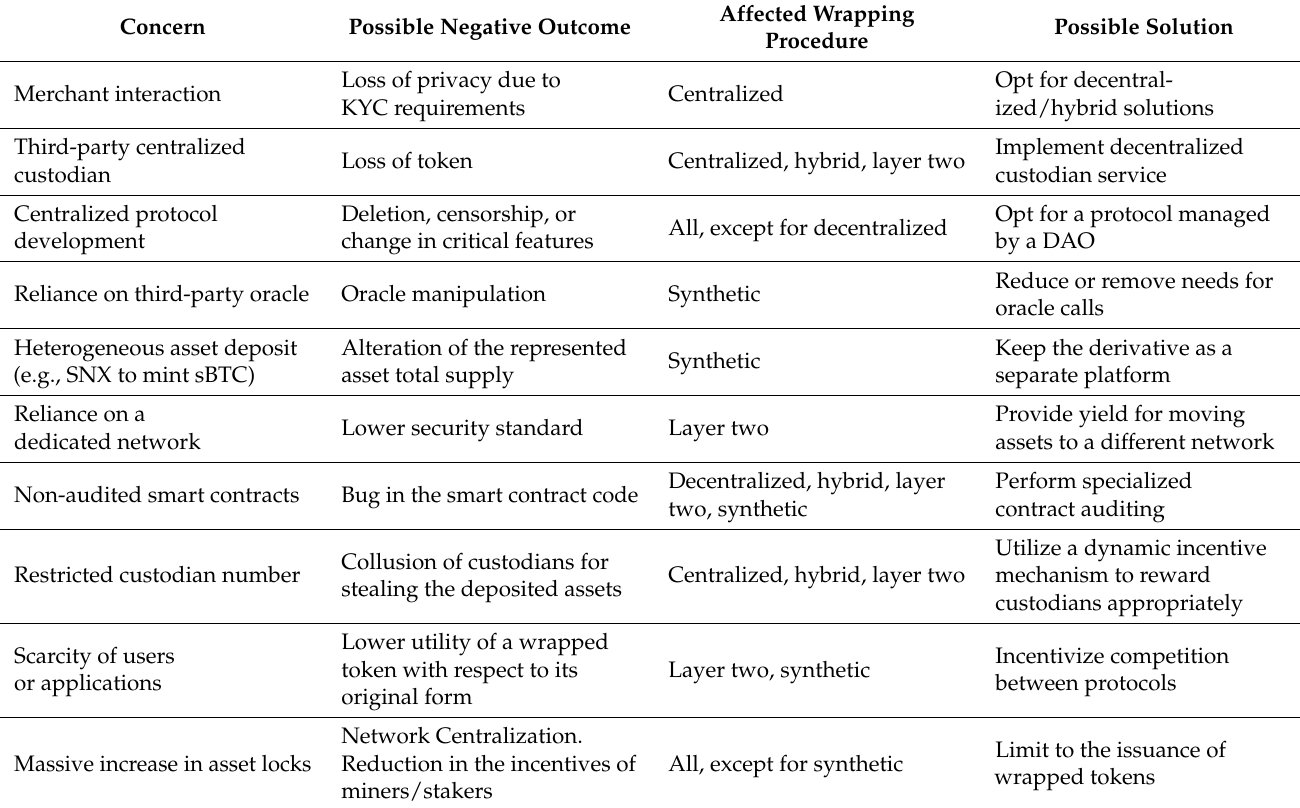
Table 8. Wrapping concerns, outcomes, and possible